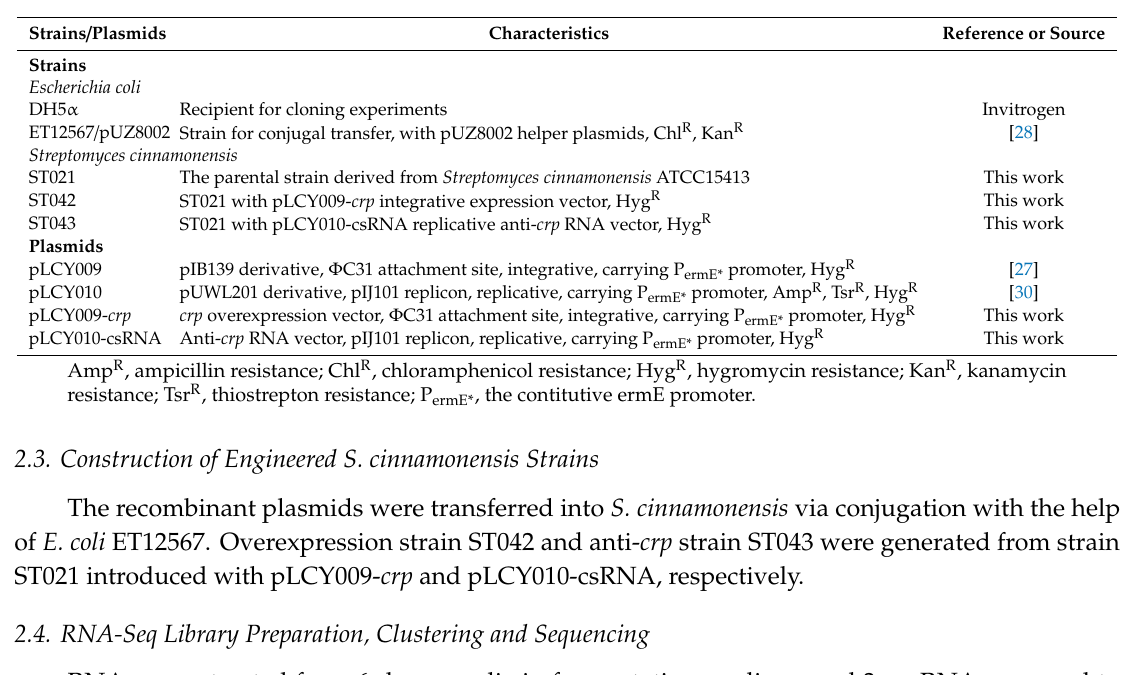
Table 1. Bacterial strains and plasmids used in this